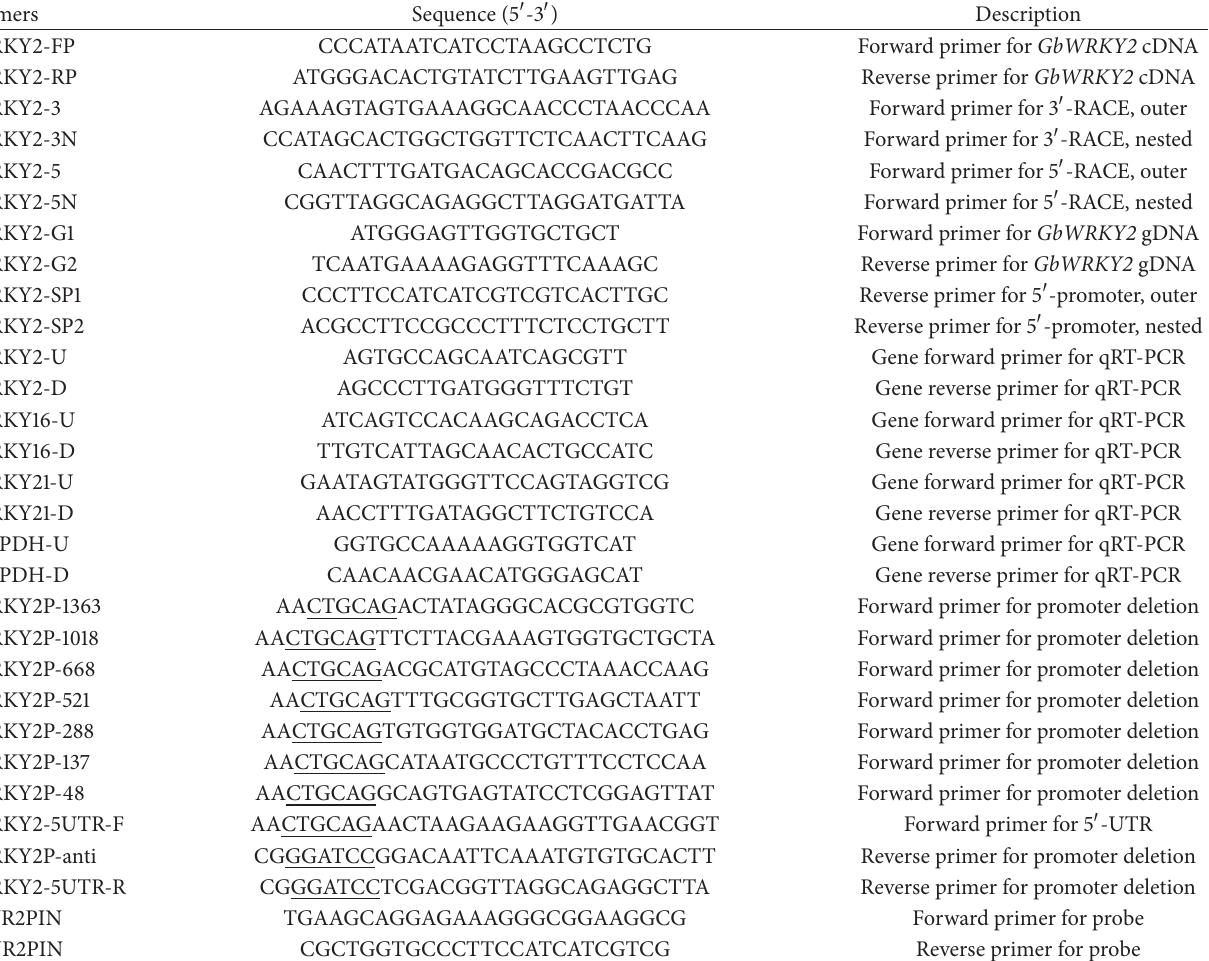
Table 1: The primers used in this